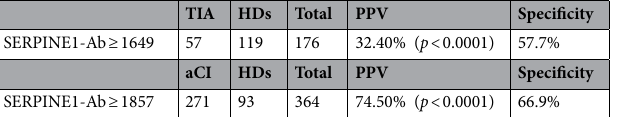
Table 2. Positive predictive value for TIA and aCI. The positive predictive values and specificity for TIA and aCI were calculated using the SERPINE1 cutoff values obtained from the receiver operating characteristic curve analysis. TIA transient ischemic attack, HDs healthy donors, PPV positive predictive value, aCI acute cerebral infarction, Ab antibody.